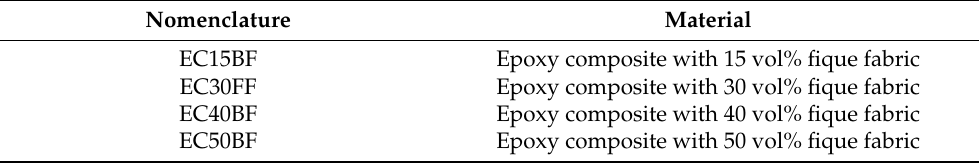
Table 1. Nomenclature adopted for the composites.